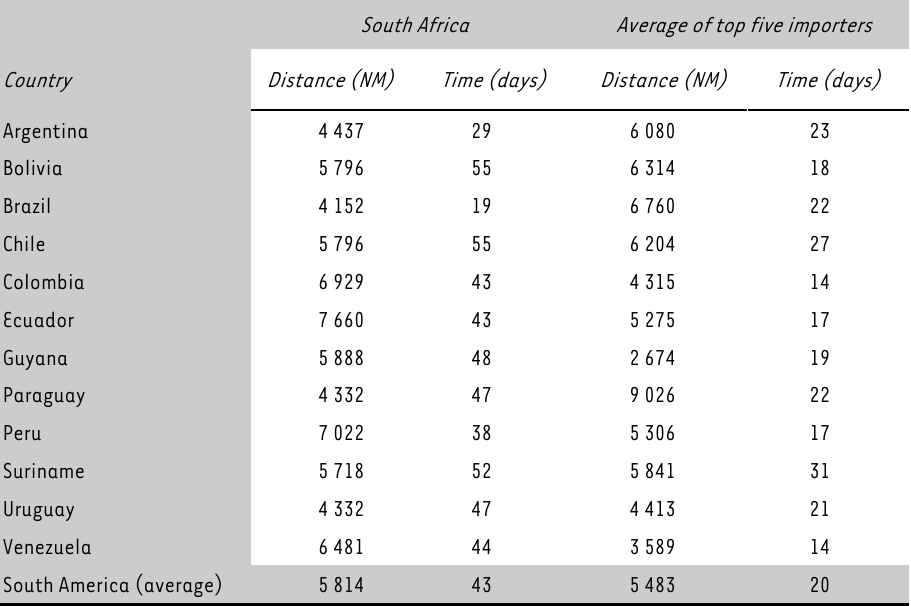
TABLE 3: Distances and shipping times between South Africa and each South American country, and between South America and its top five importers South Africa Average of top five importers Country Distance (NM) Time (days) Distance (NM) Time